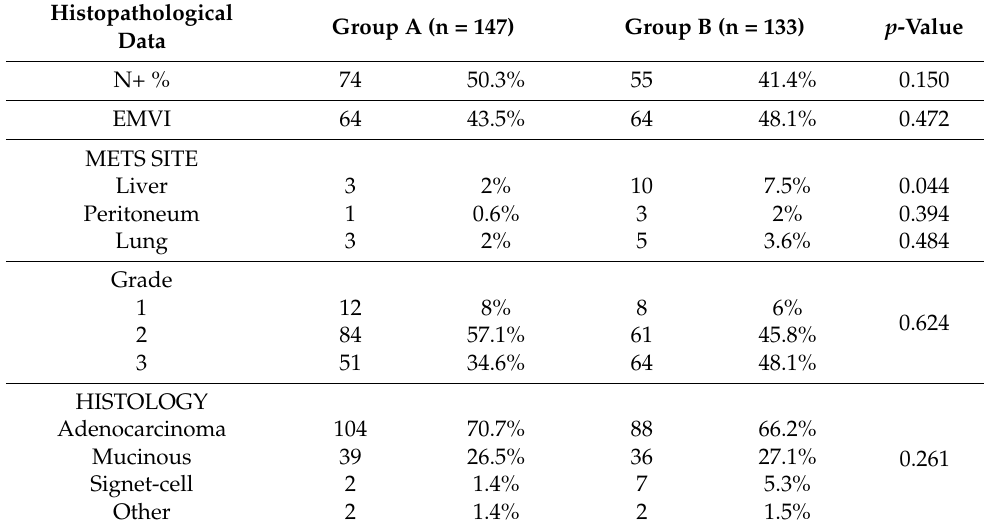
Table 4. Histopathological